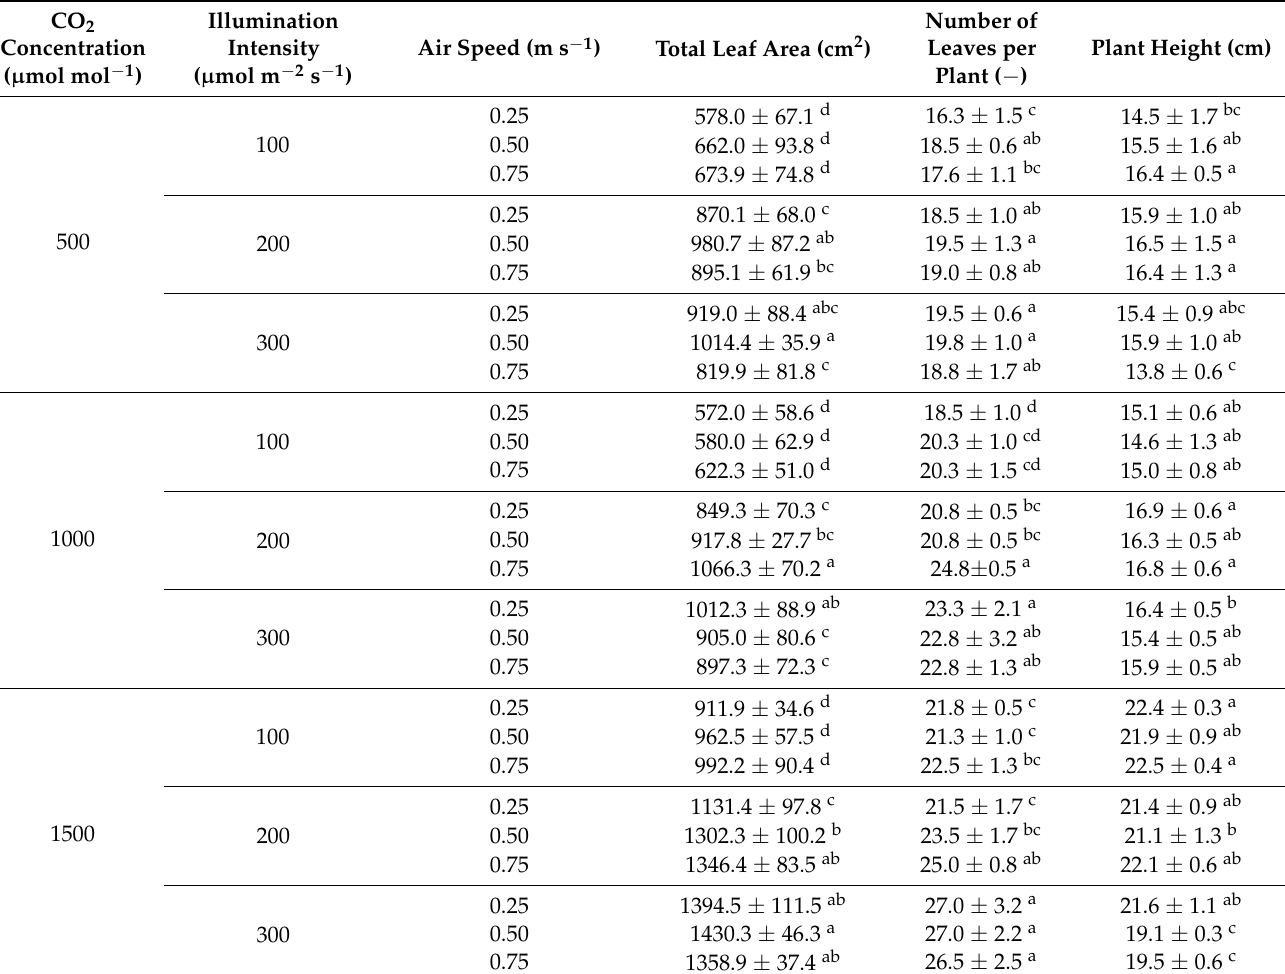
Table 2. Total leaf area, number of leaves and plant height of lettuce plants as affected by CO 2 concentration, illumination intensity and air